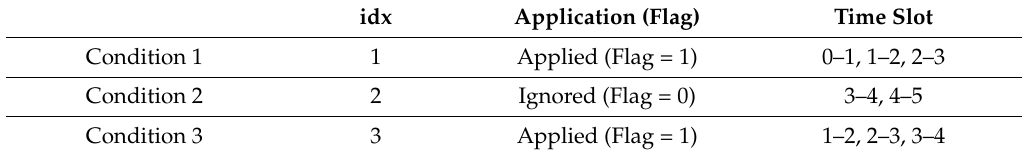
Table 10. Net-zero operating